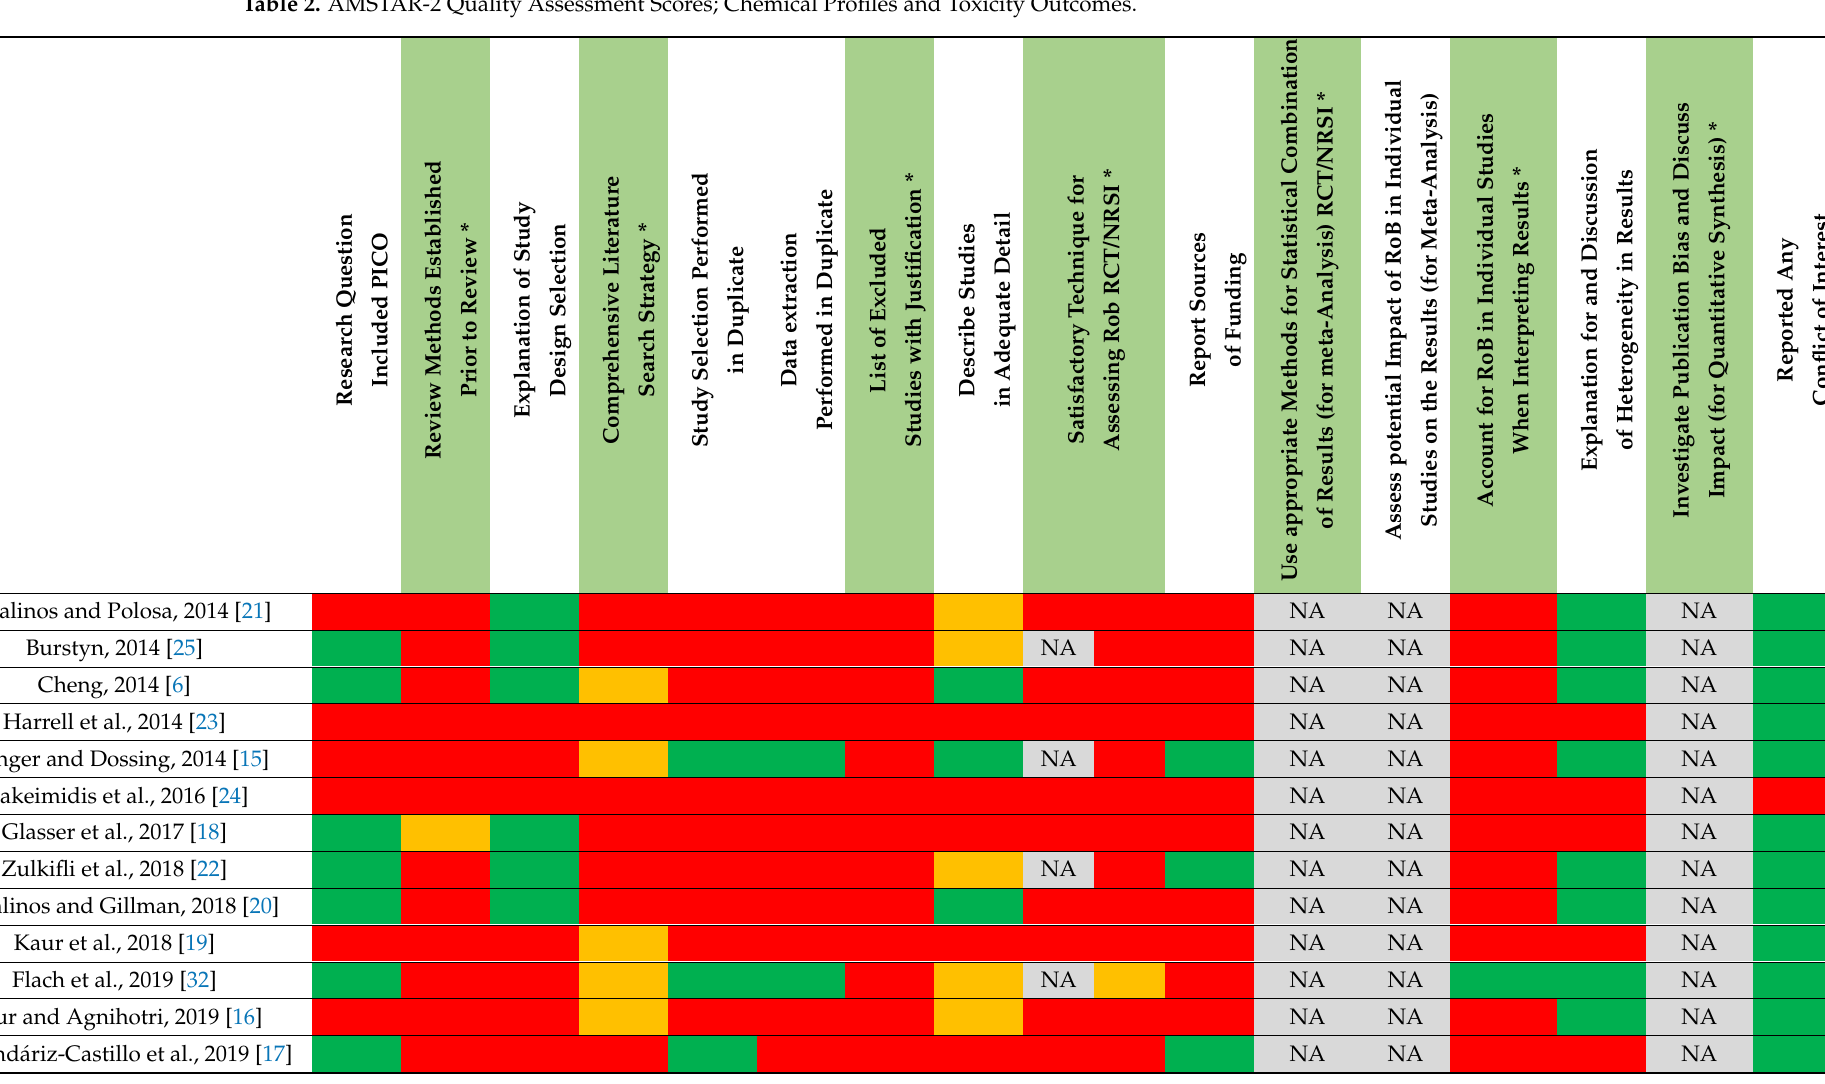
Table 2. AMSTAR-2 Quality Assessment Scores; Chemical Profiles and Toxicity